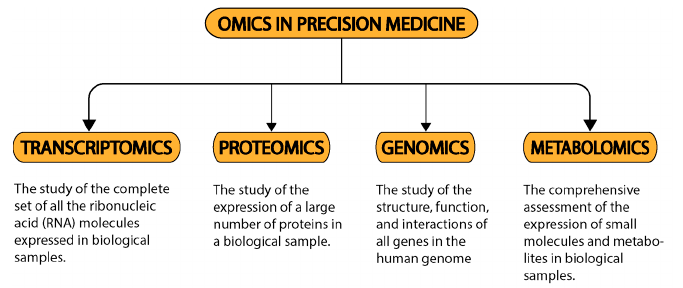
Figure 1. The OMICS in precision medicine.